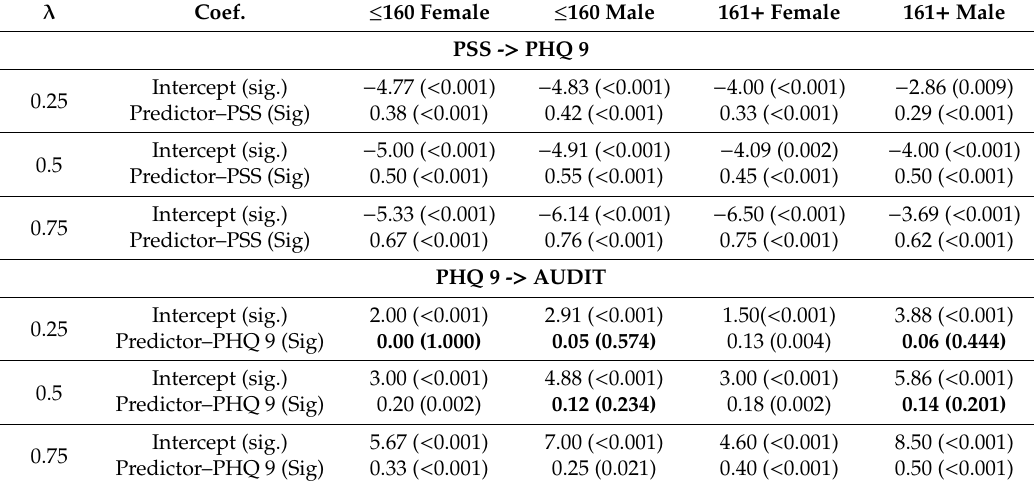
Table 6. Quantile regression analysis output.